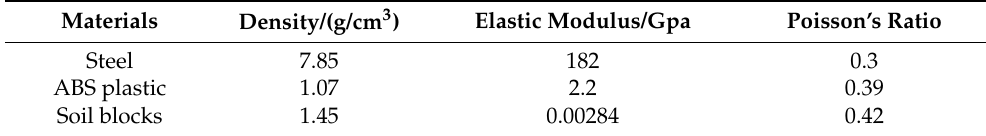
Table 1. Properties of collision